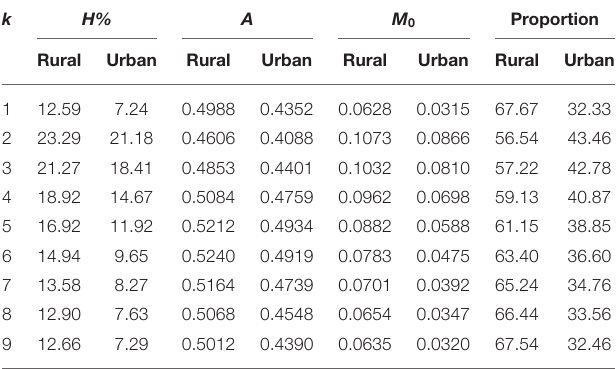
TABLE 6 | Decomposition of MHPI by rural and